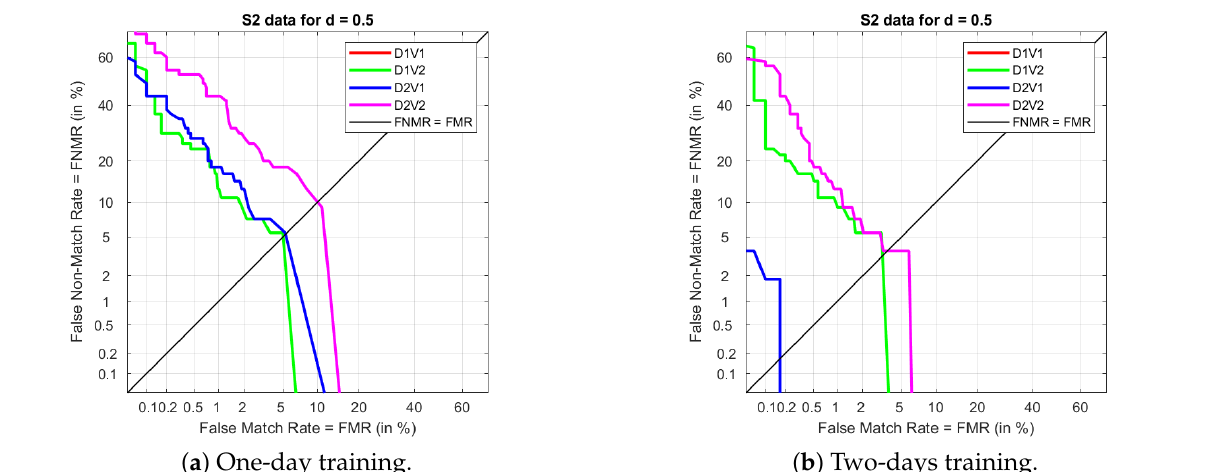
Figure 8. Performance results using data from S1.